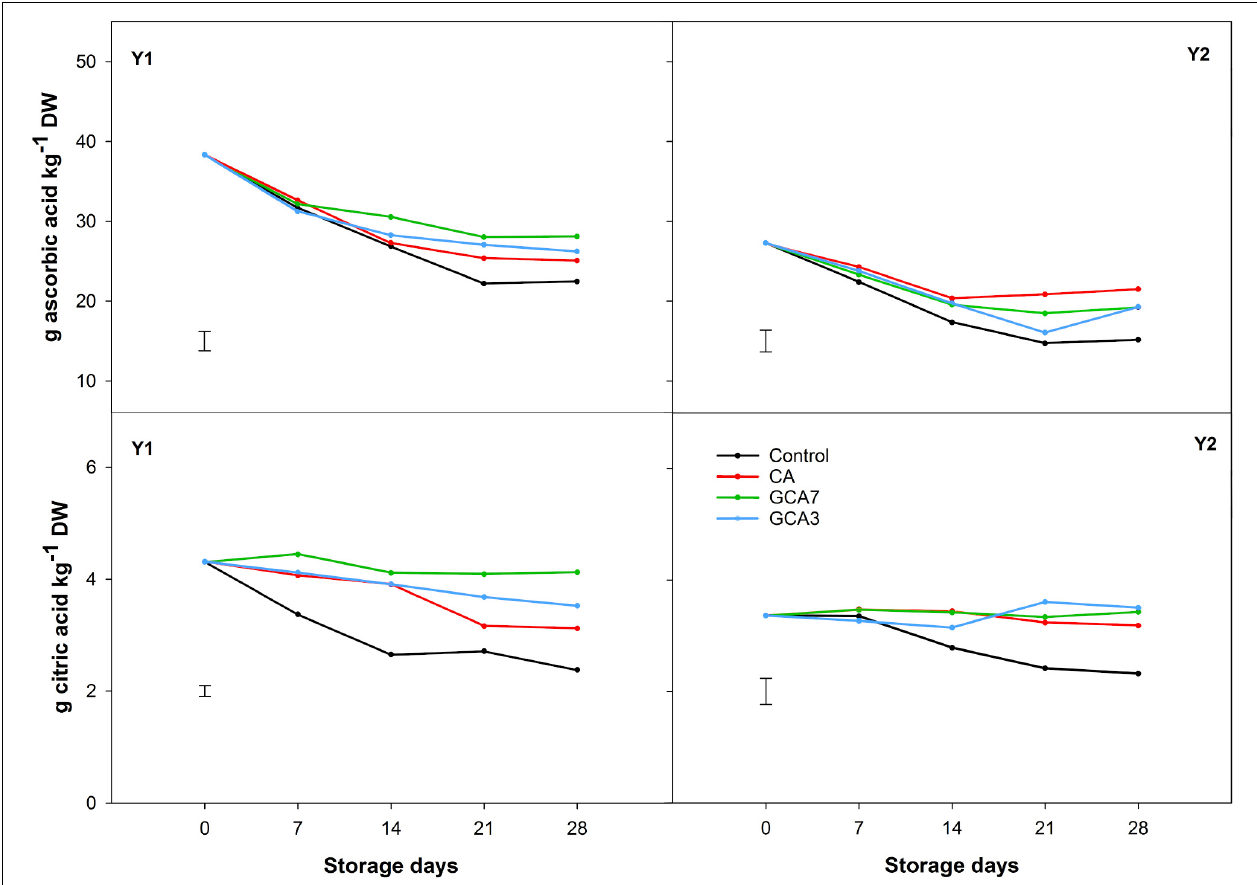
FIGURE 7 | Organic acid concentration (ascorbic and citric acids) expressed as g kg − 1 dry weight (DW) of “Duke” blueberry fruit subjected to controlled atmosphere (CA) applications throughout 28 days of storage at 0 ◦ C and 90–95 RH%; air [control]; standard CA (10 kPa CO 2 + 5 kPa O 2 ); graduated CA 7 (GCA7; 7 days to achieve standard CA values); and GCA3 (3 days to achieve standard CA values). Two consecutive seasons are considered 2017 (year 1; Y1) and 2018 (Y2). Data represents means ( n = 3). Least Significant Differences (LSD) are included as: (i) ascorbic acid – LSD treatment = LSD time = 2.417 for Y1 and LSD treatment = 2.731 for Y2; and citric acid – LSD treatment = LSD time = 0.1907 for Y1 and LSD treatment = 0.4680 for